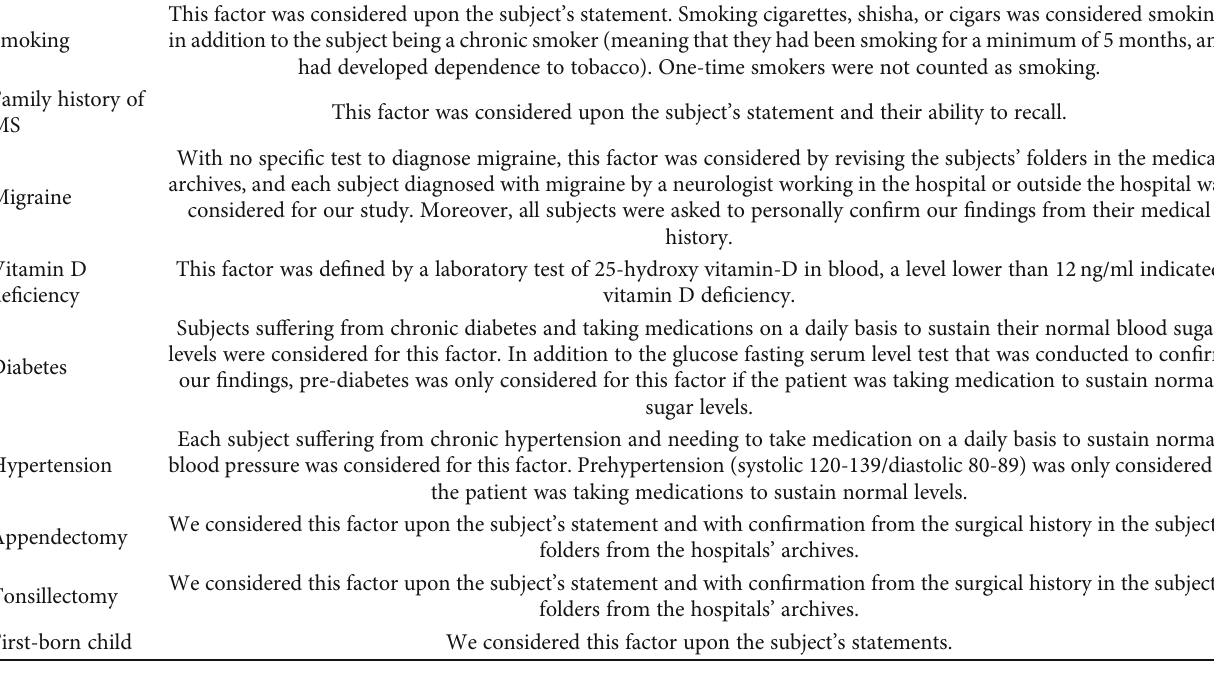
Table 1: Detailed inclusion criteria for each risk factor included in the study.